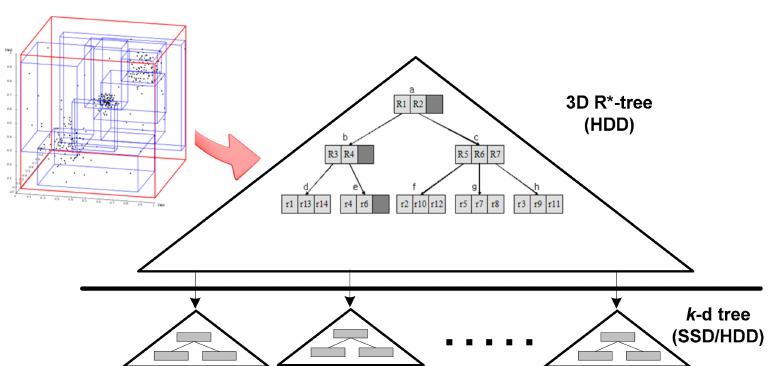
Figure 6. Two-step index structure based on minimum bounding box (MBB) approximation and